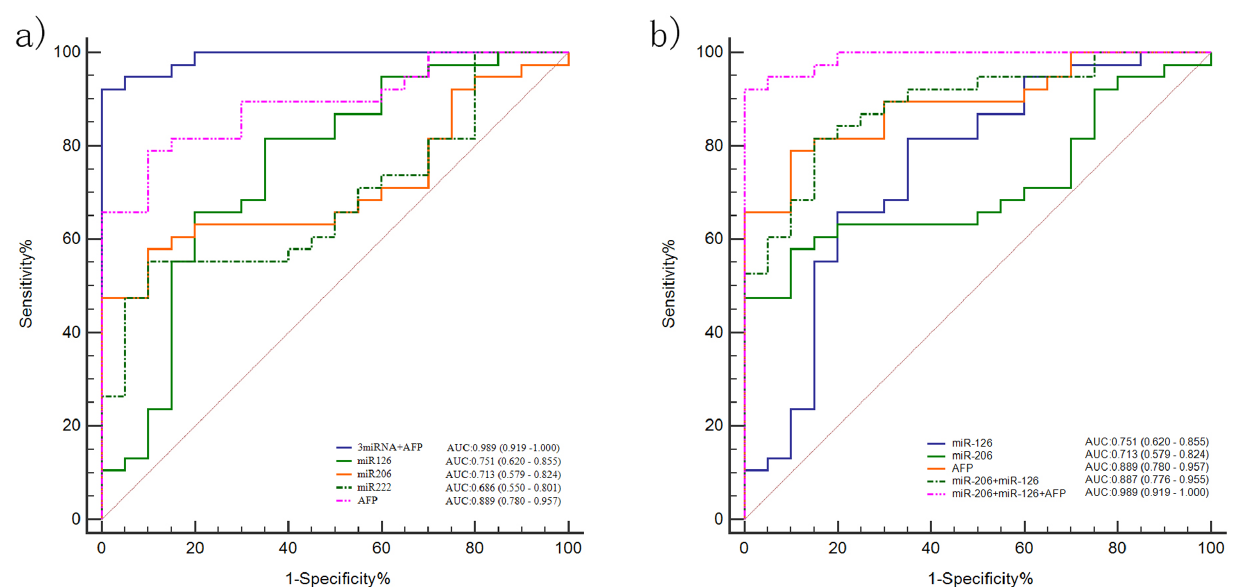
Figure 5. Evaluation of sensitivity and specificity between miRNA and the combination of miRNA and AFP as diagnostic markers. miRNA, microRNA; AFP, α